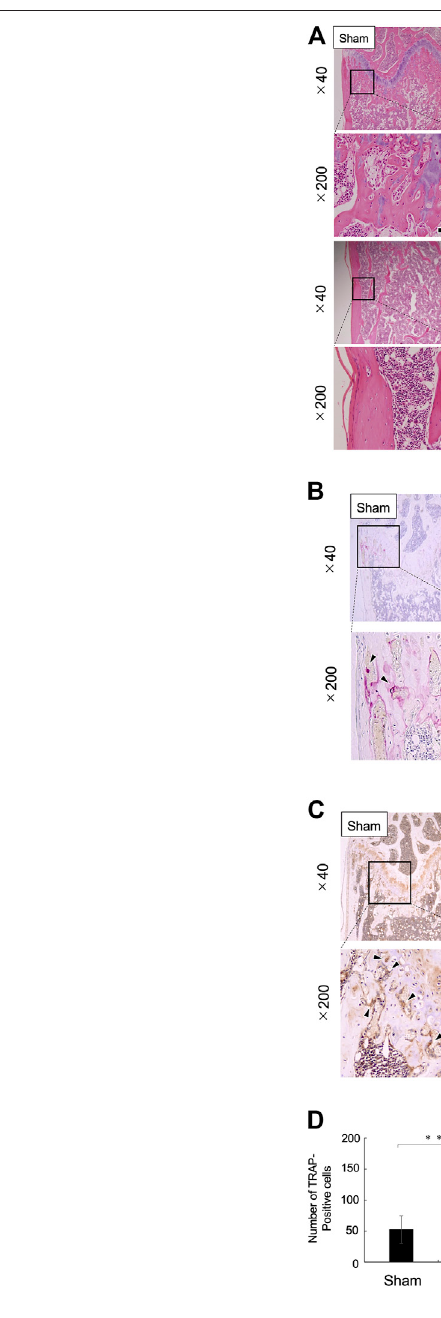
Frontiers in Pharmacology |